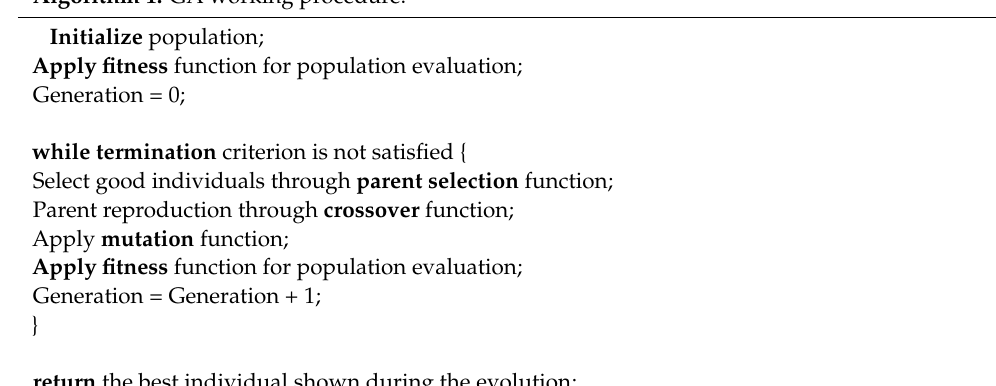
Algorithm 1. GA working